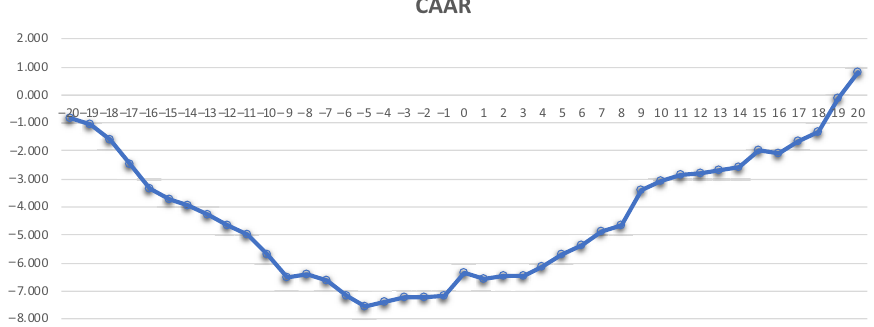
Figure 3. Cumulative average abnormal returns (CAARs) during the event